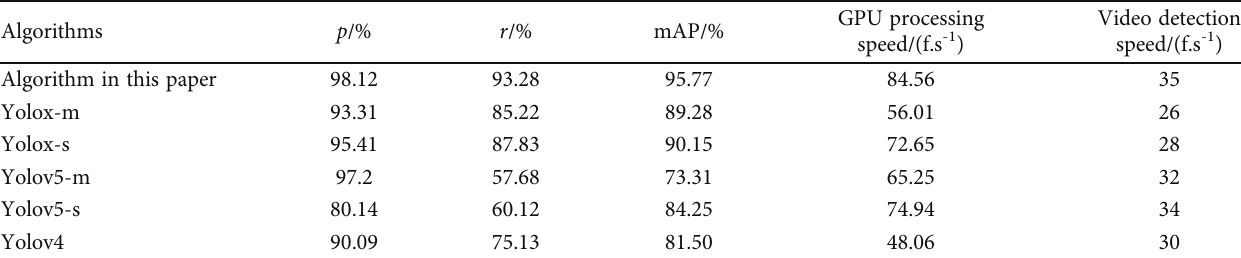
Table 3: Performance comparison of six